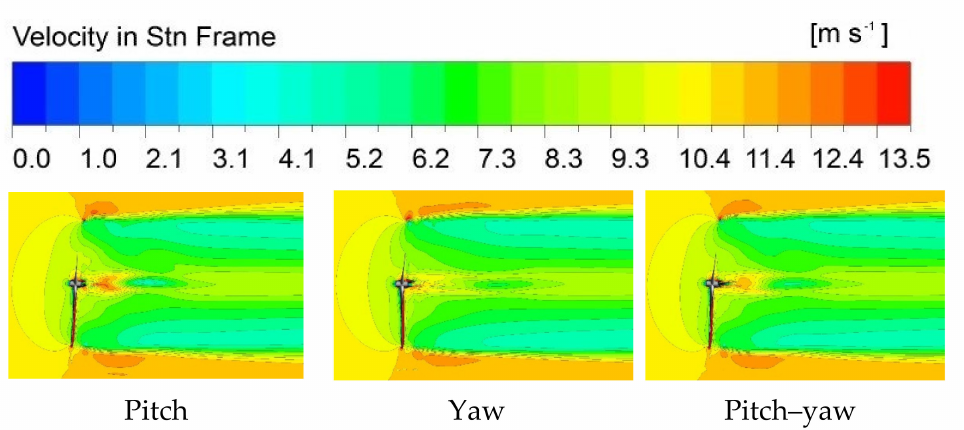
Figure 17. Velocity distribution at Position